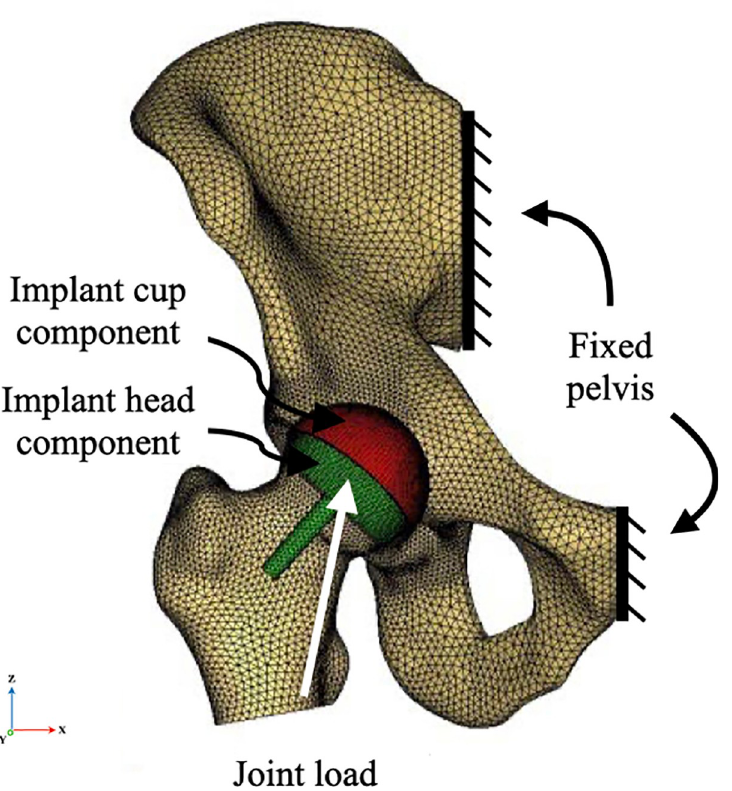
Fig 1. Finite element (FE) model of the hip resurfacing arthroplasty (HRA). https://doi.org/10.1371/journal.pone.0252435.g001 PLOS ONE | https://doi.org/10.1371/journal.pone.0252435 May 27,